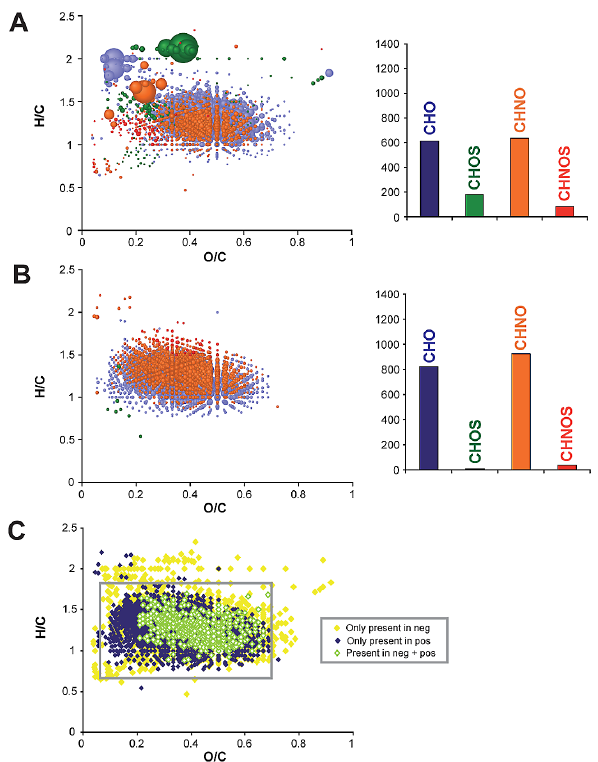
Fig. 18. Van Krevelen diagram derived from consolidated ions ob- served in all four marine SPE-DOM. (A) Common negative ions with (right panel) given counts according to molecular series; (B) common positive ions with (right panel) given counts according to molecular series; (C) overlay of the respective covered C,H,O- compositional space for consolidated positive (purple) and nega- tive (bright blue) ions from all (CHO, CHNO, CHOS and CHNOS) molecular series.